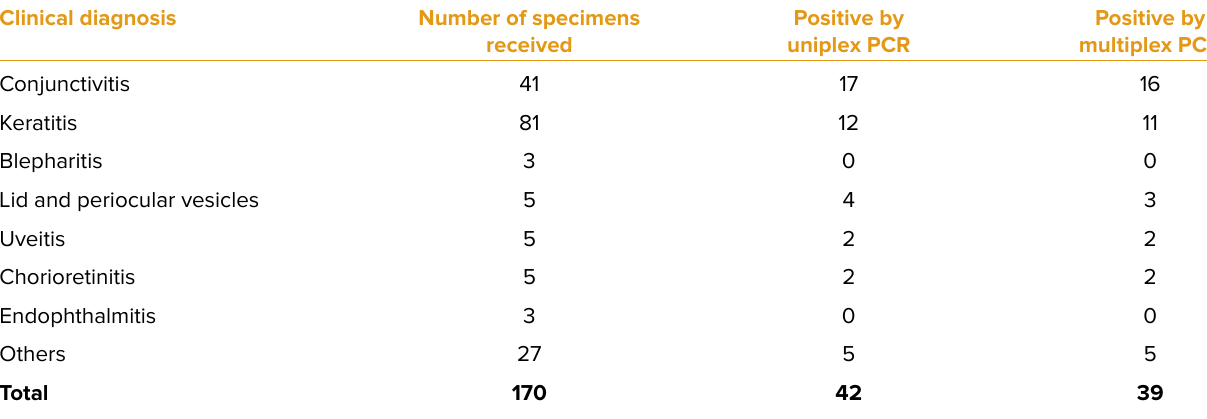
Table 3. Results of uniplex and multiplex PCRs from patients with different clinical diagnosis Clinical diagnosis Number of specimens